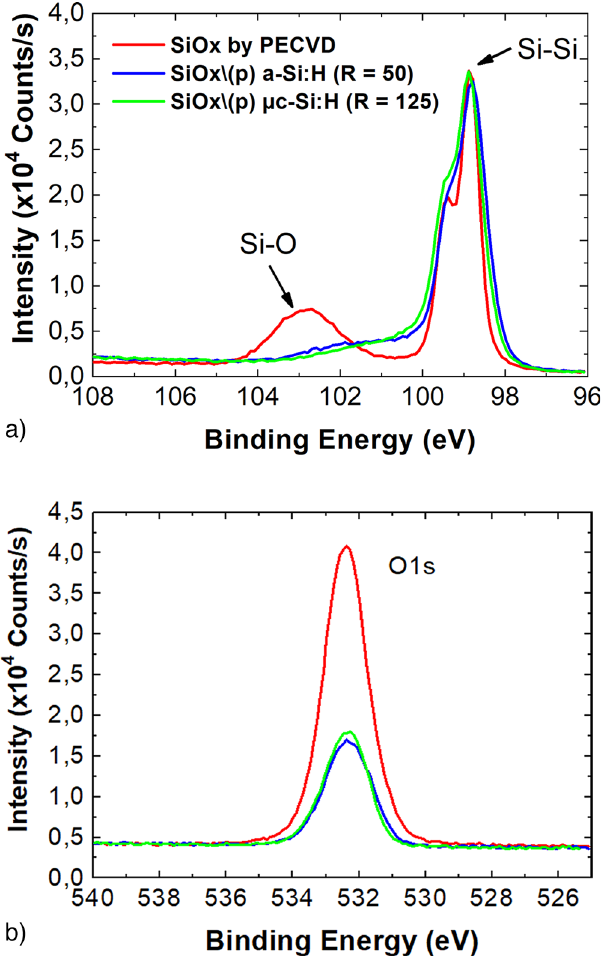
Fig. 4. (a) Si2p and (b) O1s spectra at the surface of the oxide layer (Batch 1). Figure4bshowsthecorrespondingO1sphotopeaks.Itcanbe